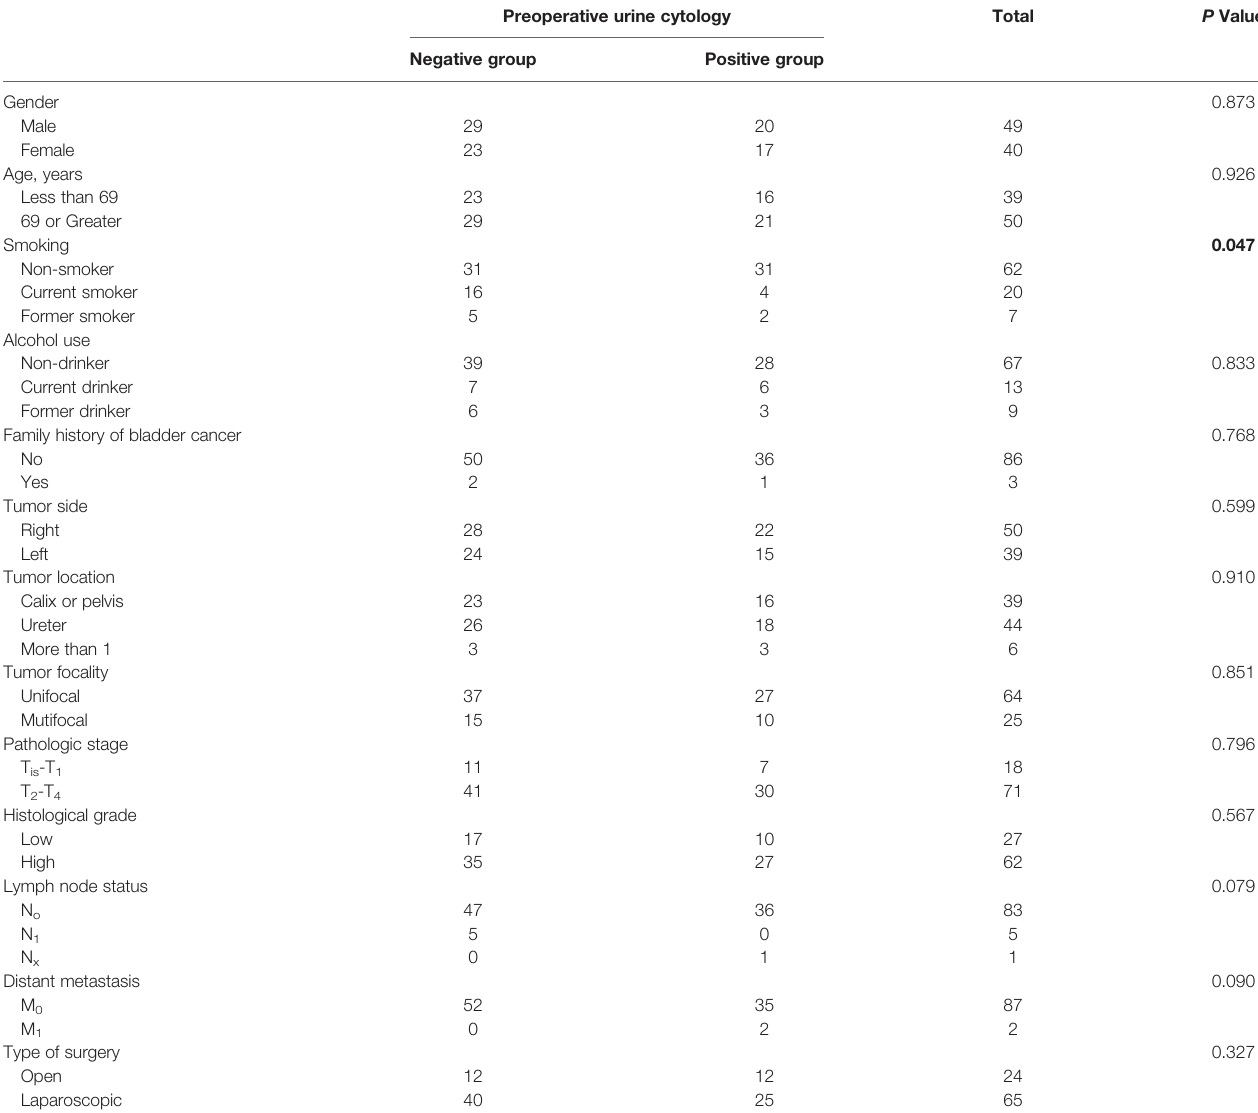
TABLE 2 | Demographics and clinicopathologic characteristics of 89 patients treated with RNU for UUT-UC in validation cohort. Preoperative urine